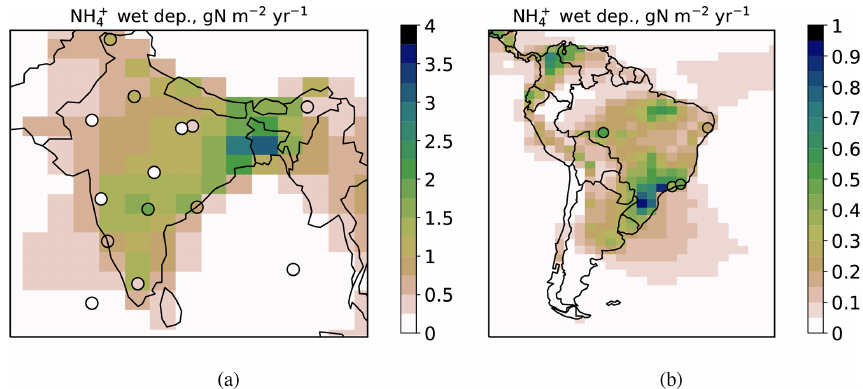
+ wet deposition (gNm − 2 yr − 1 ) over (a) India and (b) South America in the FAN simulation (shading) and in Figure 12. The modeled NH 4 the observations listed in Table A1 (markers). The other simulations are shown in Figs. S13 and S15.